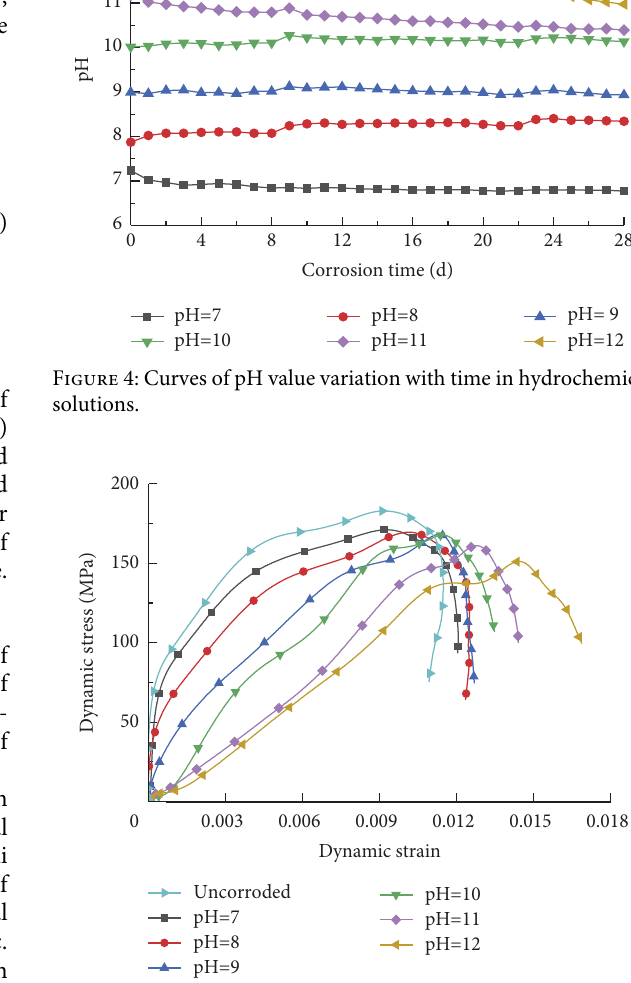
Figure 5: Dynamic stress-strain curves on sandstone specimens under erosion with different pH